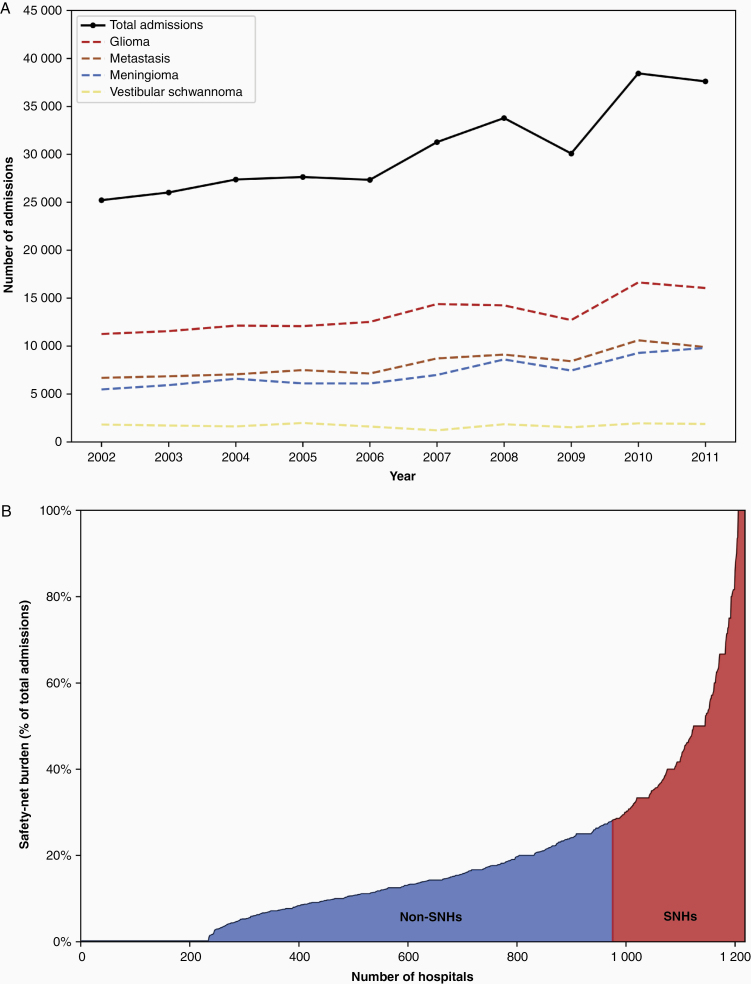
Nationwide admissions for brain tumor craniotomy. (A) Number of admissions from 2002 to 2011 for craniotomy for all brain tumors and each subtype. (B) Cumulative plot of all 1,206 hospitals in the study population, in ascending order by their respective safety-net burden (y-axis). Safety-net burden was quantified as the number of Medicaid and uninsured admissions divided by total admissions. Two hundred and forty-two hospitals were classified as safety-net hospitals, with the threshold for classification being a safety-net burden of ≥28.6%.